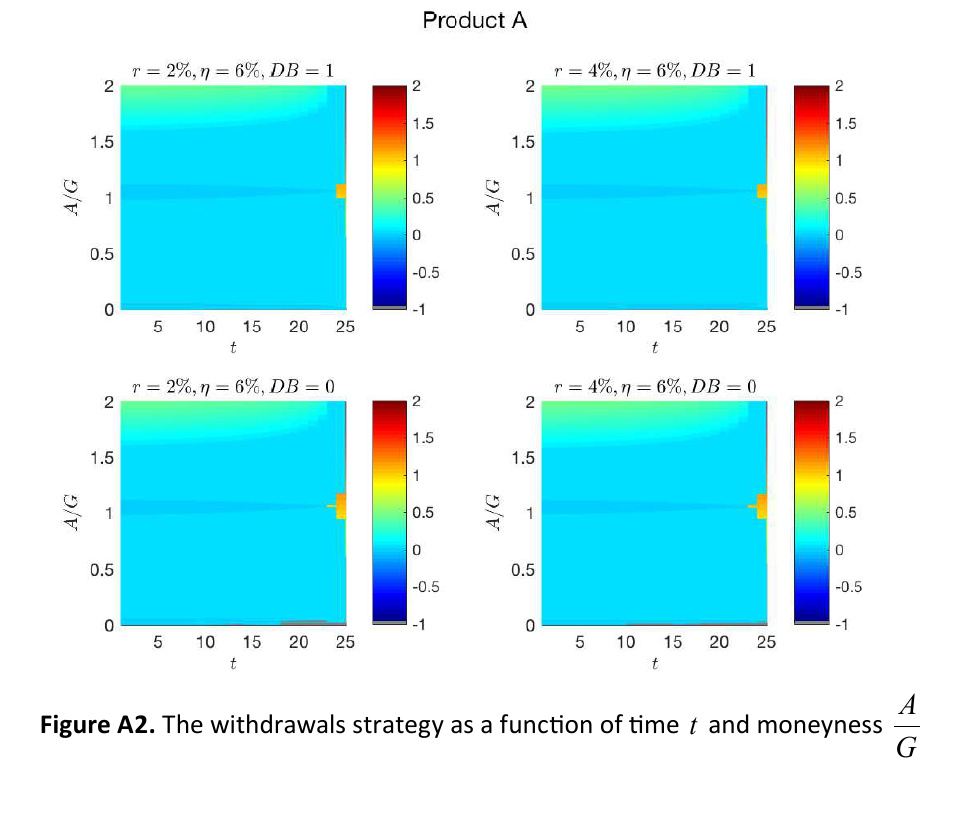
Figure A2. The withdrawals strategy as a function of time t and moneyness